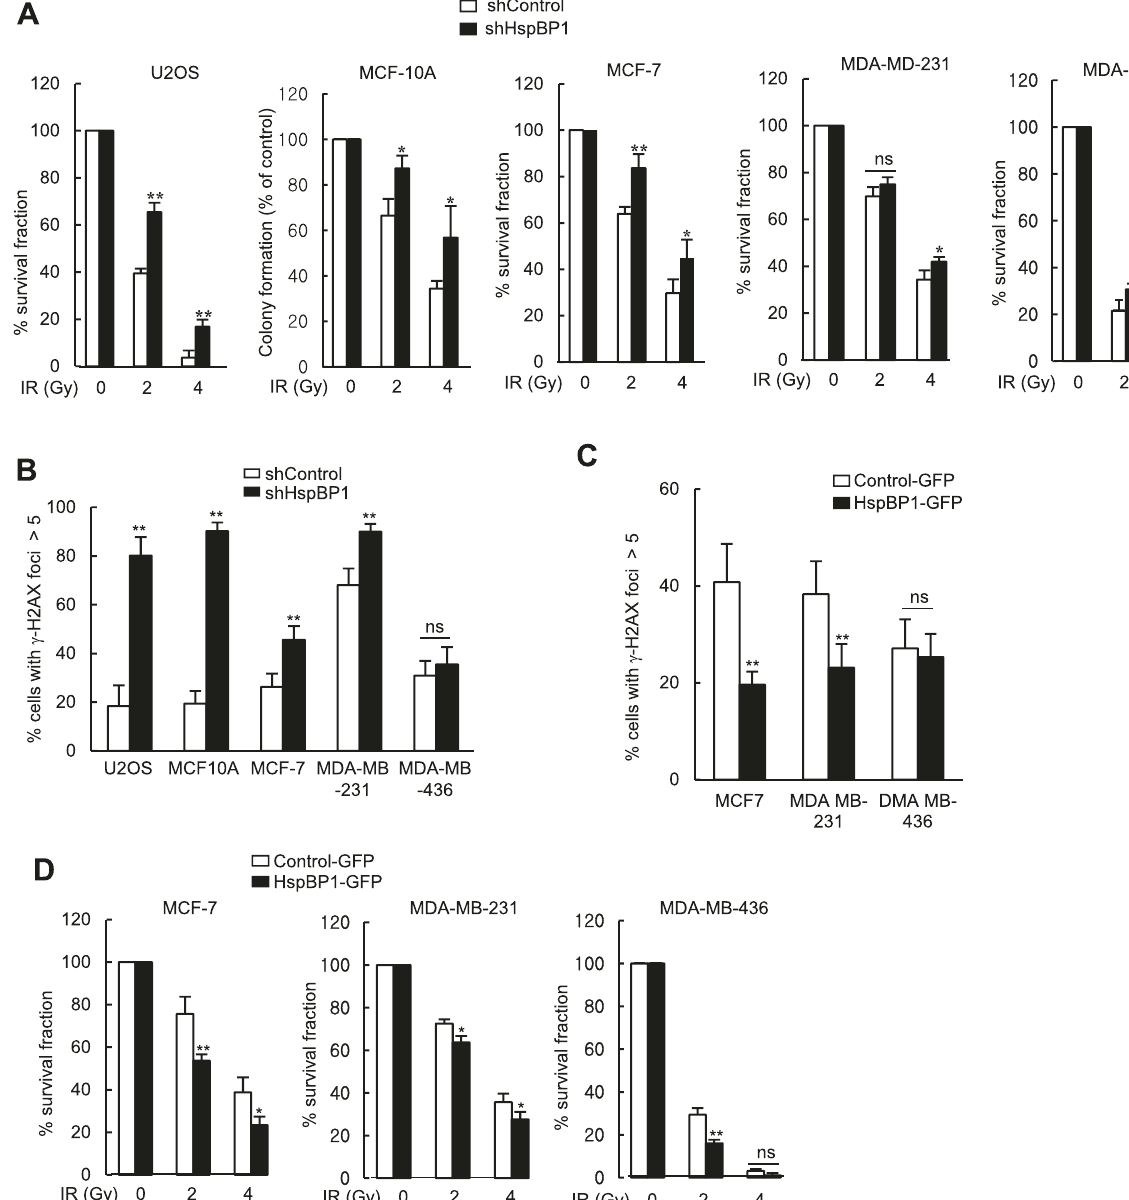
Fig. 6 HspBP1 contributes to IR resistance. A Control and HspBp1-depleted U2OS, MCF-10A, MCF-7, MDA-MB-231, and MDA-MD-436 cells were either untreated or treated with the indicated doses of IR. The viability of untreated and treated cells were examined using the clonogenic survival assay. Results are shown as the mean ± SD ( n = 3), ** P < 0.01, * P < 0.05, ns, not signi fi cant. two-tailed Student ’ s t -test. B γ - H2AX foci of the same cells as described in ( A ). Cell were treated with 5 Gy of IR, fi xed at 24 h, and immunostained using an anti- γ -H2AX antibody. The percentage of cells with more than 5 γ -H2AX foci is shown. Results are shown as the mean ± SD ( n = 3), ** P < 0.01, ns Not signi fi cant, two-tailed Student ’ s t -test. C Control and HspBP1-GFP-expressing MCF7, MDA-MB-231, and MDA-MB-436 cells were treated with 5 Gy of IR, fi xed at 12 h after, and immunostained using antibody against γ -H2AX. The percentage of cells with more than 5 foci for γ -H2AX is shown. Results are shown as the mean ± SD ( n = 3), ** P < 0.01, ns Not signi fi cant, two-tailed Student ’ s t -test. D A clonogenic survival assay of the same cells described in ( C ). Cells were either untreated or treated with the indicated doses of IR. Results are shown as the mean ± SD ( n = 3), ** P < 0.01, * P < 0.05, ns Not signi fi cant, two-tailed Student ’ s t -test. the control (Figs. 6B, and S5A). However, even though HspBP1- number of colonies that grew, was higher than that of control cells overexpressing MCF-7 and MDA-MB-231 cells showed higher (Fig. 6A) suggesting that the radioresistance conferred in the numbers of unrepaired DSBs in response to IR and HspBP1- absence of HspBP1 occurred in all cells regardless of BRCA1 status. overexpressing MDA-MB-436 cells did not (Figs. 6C, and S5B), all Of note, HspBP1-depleted U2OS, MCF10A, MCF-7, and MDA-MB- the HspBP1-overexpressing cell lines were more sensitive to IR 231 cells (BRCA1-pro fi cient), but not HspBP1-depleted MDA-MB- treatment than control cells (Fig. 6D). Since depletion of HspBP1 436 cells (BRCA1-de fi cient), showed an increase in the number of increases anchorage-independent cell growth (Fig. 1A, B), the unrepaired DSBs after IR-induced DNA damage as evidenced by ability of HspBP1 for tumorigenesis may also affect cell survival in the number of γ -H2AX foci that were retained as compared with